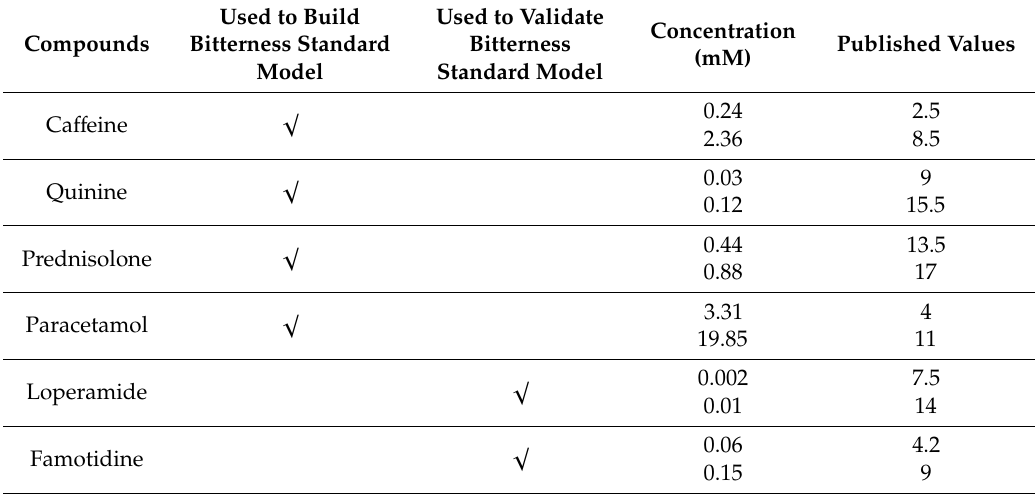
Table 1. Compounds with known bitter scores from a human sensory analysis panel